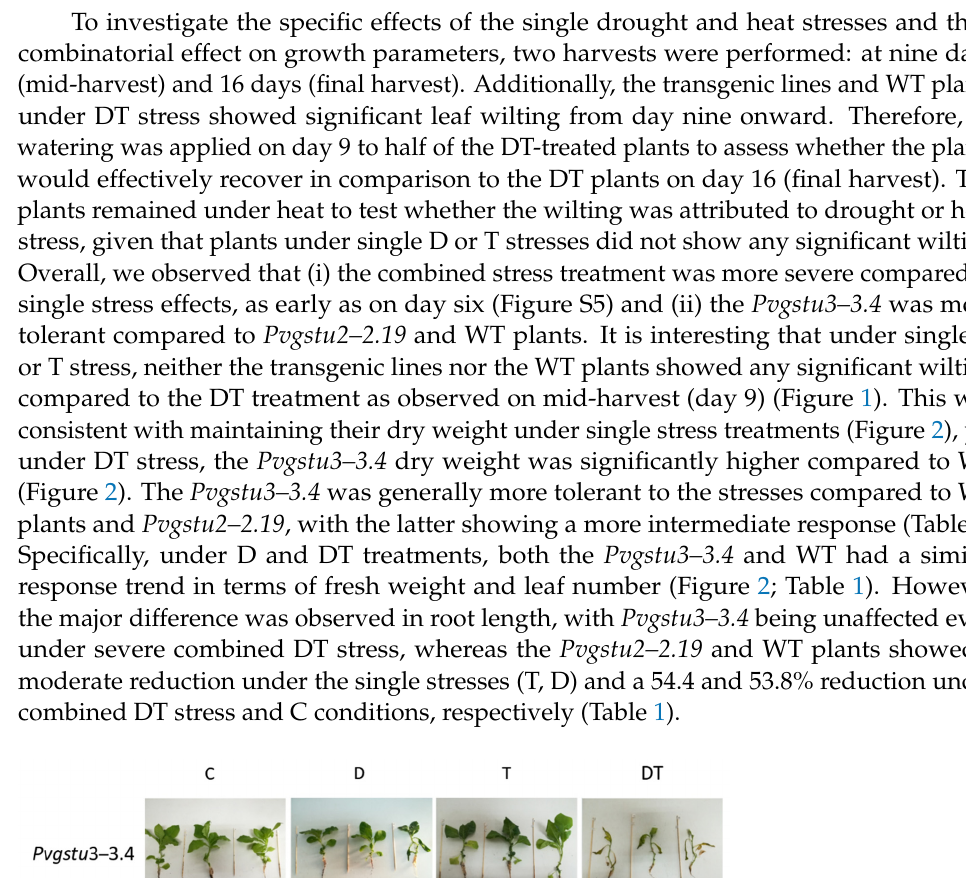
Figure 2. Dry matter (M D ) (g) of the transgenic lines Pvgstu3–3.4 and Pvgstu2–2.19 and WT plants growing under control (C), drought (D), heat (T) and combination of drought and heat stresses (DT) at nine and 16 days. Different letters indicate significant differences among genotypes for each treatment at p < 0.05. Data are means ± SE (WT: n = 4; Pvgstu lines at 9 days: n = 5; at 16 days: n = 7). Table 1. Growth traits of the Pvgstu transgenic lines and WT tobacco plants grown for nine days in drought (D), heat (T) and a combination of drought and heat (DT) stresses. Tukey’s HSD (T HSD ) post hoc test was performed for the treatment effect on shoot and root length, fresh matter (M F ) and the number of leaves for each genotype. Data are means ± SE (WT: n = 4; Pvgstu lines: n = 5). Different letters indicate significant differences between treatments for each genotype at p < 0.05. Mid-harvest (Day 9) Genotypes Treatment Shoot Length T HSD Root Length T HSD M F T HSD Number of leaves T HSD Pvgstu2–2.19